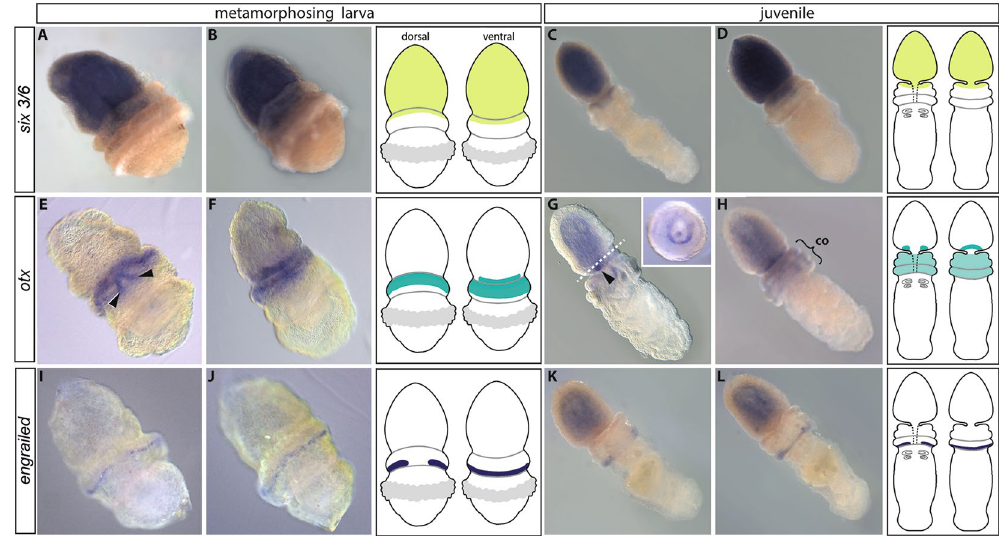
Figure 2. Anteroposterior patterning genes allocate the collar cord of B. misakiensis to the chordate brain region. Anterior is to the top left. ( A – D) BmiSix3/6 is expressed throughout the ectoderm of the proboscis region and the anterior collar. ( E – H) BmiOtx is expressed circumferentially in the posterior proboscis ectoderm and in the ectoderm of the collar region. ( E) Dorsal view showing an additional domain in the pharyngeal endoderm (arrowheads). ( G) BmiOtx is strongly expressed in the preoral ciliary organ (arrowhead). Section plane of inset indicated by dashed line. Inset shows Otx expression in the ciliary organ of the proboscis in a cross section of the posterior proboscis. ( I – L) BmiEn is expressed in a narrow ring in the ectoderm of the posterior end of the collar region with an interruption on the dorsal side. co = collar. ( A , C , E , G , I , K ): dorsal views. ( B , D , F , H , J , L ): ventral